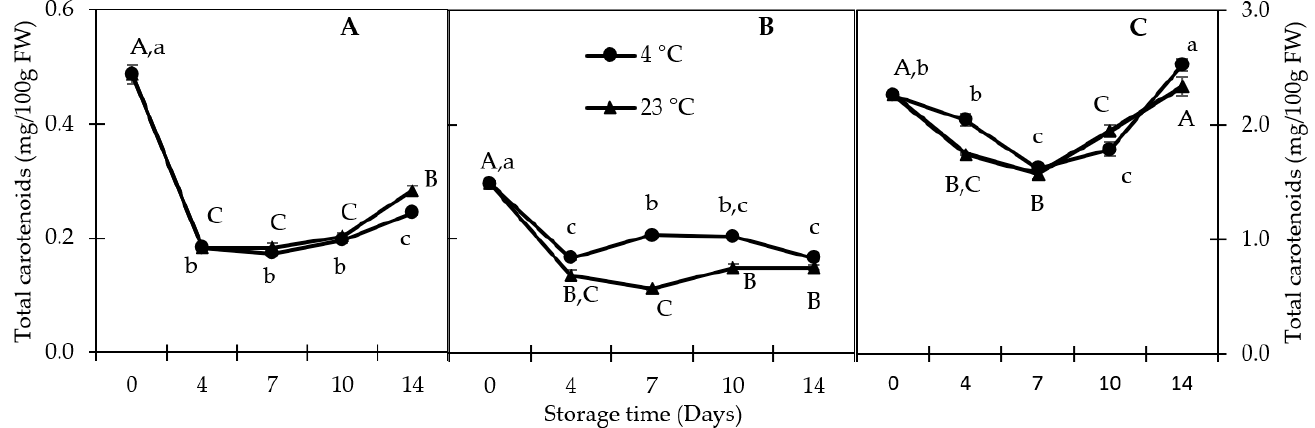
Figure 5. Carotenoids in ( A ) outer flesh; ( B ) inner flesh; ( C ) peel. Data are presented as mean ± SE ( n = 3). Different uppercase and lowercase letters indicate significant ( p < 0.05) differences between storage days.